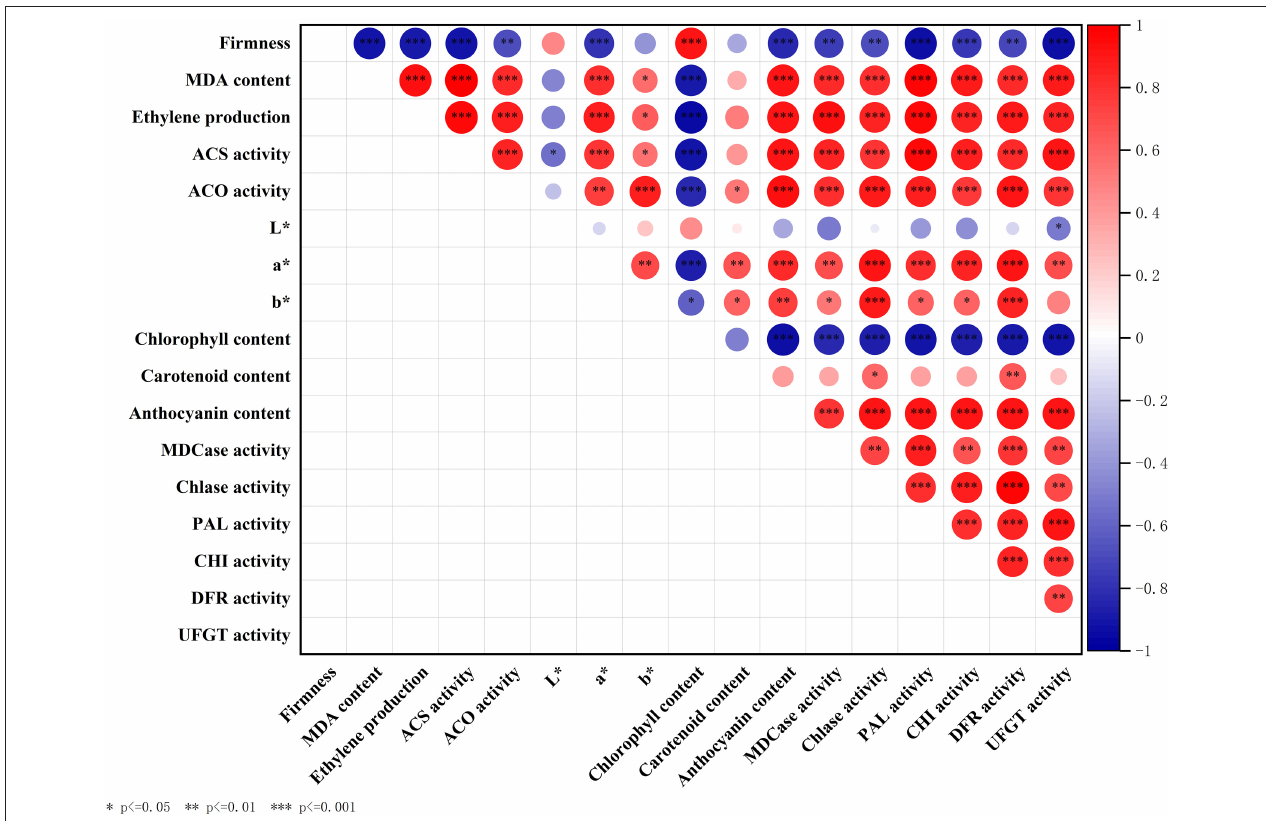
FIGURE 7 | Correlation analysis between parameters including firmness, MDA content, ethylene production, ACS activity, ACO activity, L *, a *, b *, anthocyanin content, chlorophyll content, carotenoid content, Chlase activity, MDCase activity, PAL activity, CHI activity, DFR activity, and UFGT activity. Asterisks indicate significant differences as determined by Duncan’s multiple range test (* P < 0.05, ** P < 0.01, *** P <